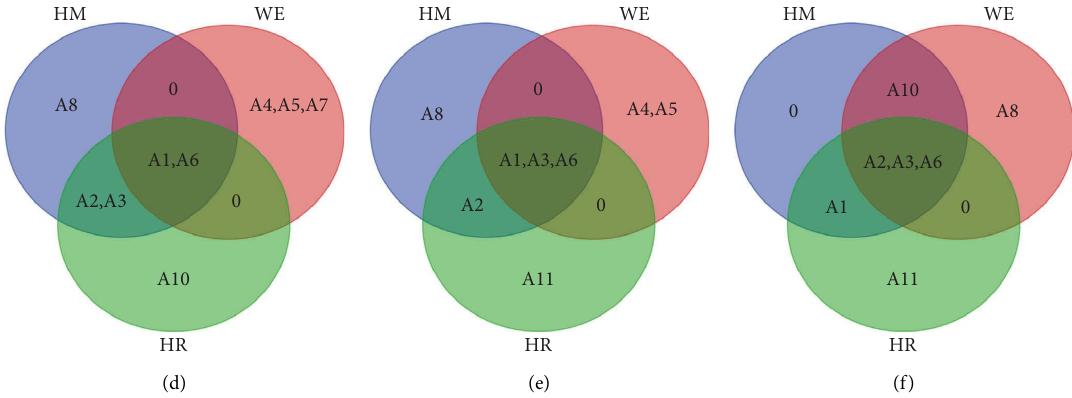
Figure 7: Venn diagrams of PLSR and BCA model: (a) DPPH assay. (b) O • − scavenging assay. (c) OH • scavenging assay were analyzed by 2 scavenging assay. (f) OH • scavenging assay were analyzed by the BCA model. Te overlapping the PLSR model. (d) DPPH assay. (e) O • − 2 section was the common peaks shard by HM, WE, and HR.